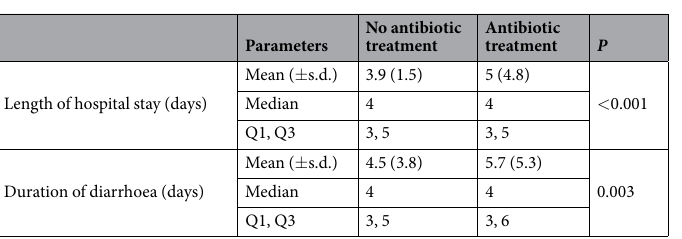
Table 5. Length of hospital stay and duration of diarrhoea in treated vs. untreated